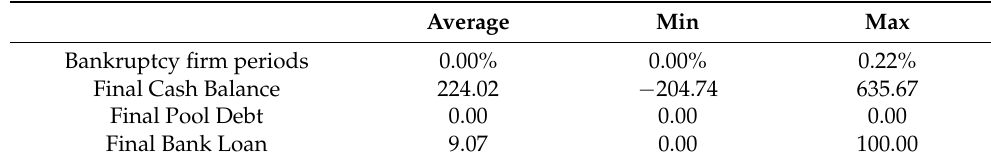
Table 3. Base case results without cooperation.